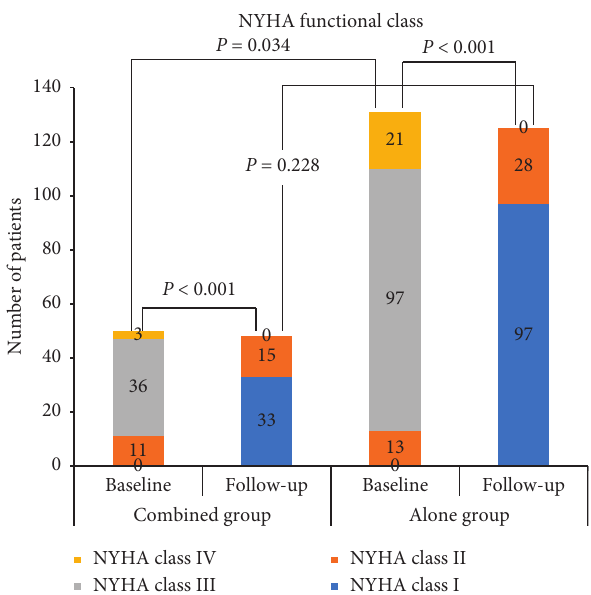
Figure 2: NYHA functional status before myectomy and at the latest follow-up.